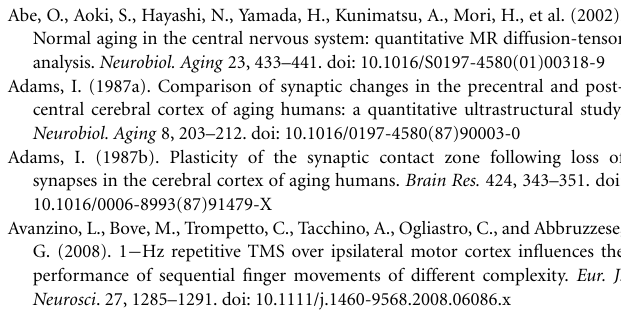
(r) and corresponding p -values are indicated on the figure (Spearman’s rank correlation). Regression lines are shown; corresponding regression slope and intercept values are indicated on the